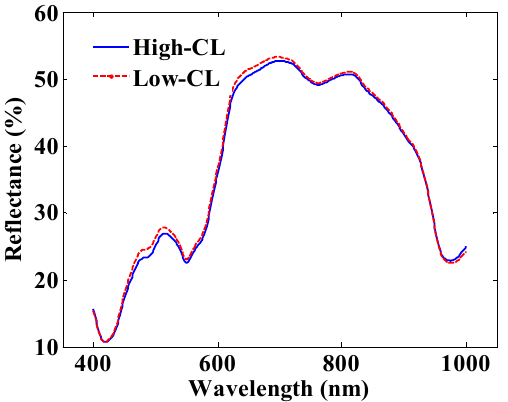
Figure 4. Mean VNIR spectra of broiler breast fillets with high CL and low CL.